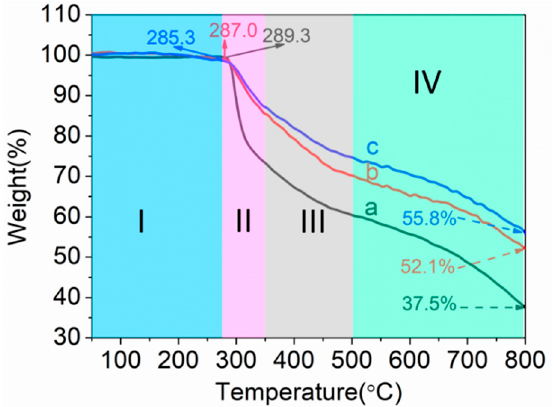
Figure 8. Thermogravimetric Analysis (TGA) curves of ( a ) PAN homopolymer, ( b ) PAN-IA0.5 copolymers, and ( c ) PAN-IA1.0 copolymers in a nitrogen atmosphere. Table 5. Thermogravimetric Analysis (TGA) data of thermal stability for the different PAN polymers.